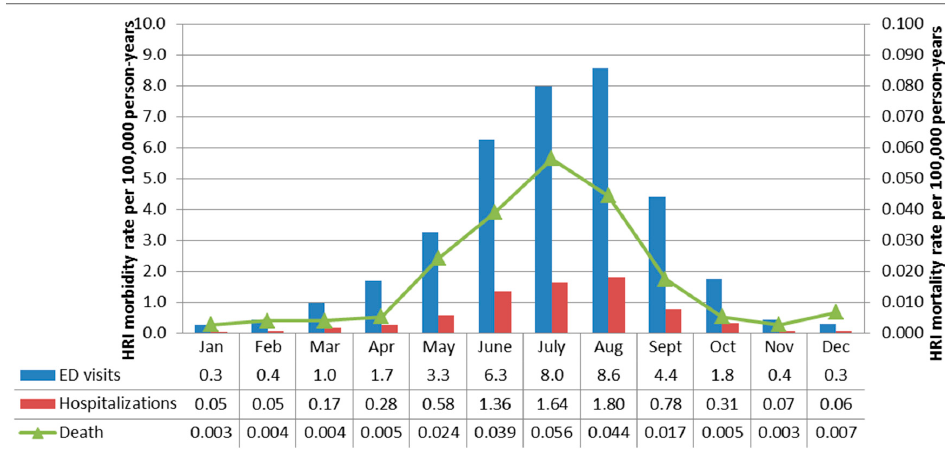
Figure 1. Non-work-related HRI morbidity and mortality rates for Florida residents stratified by month and data source, 2005–2012 (Total cases: ED visits = 27,028; Hospitalizations = 5324; Deaths = 158). All rates are per 100,000 person-years. Note that the morbidity rates (left y-axis) are two orders of magnitude larger than the mortality rates (right y-axis).